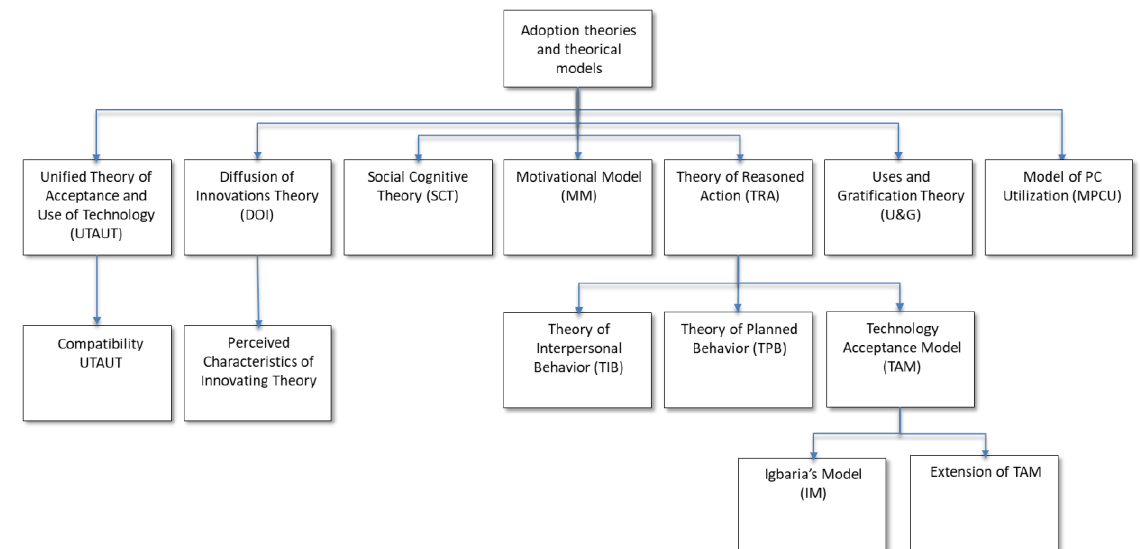
Figure 2. Adoption theories and theoretical models.